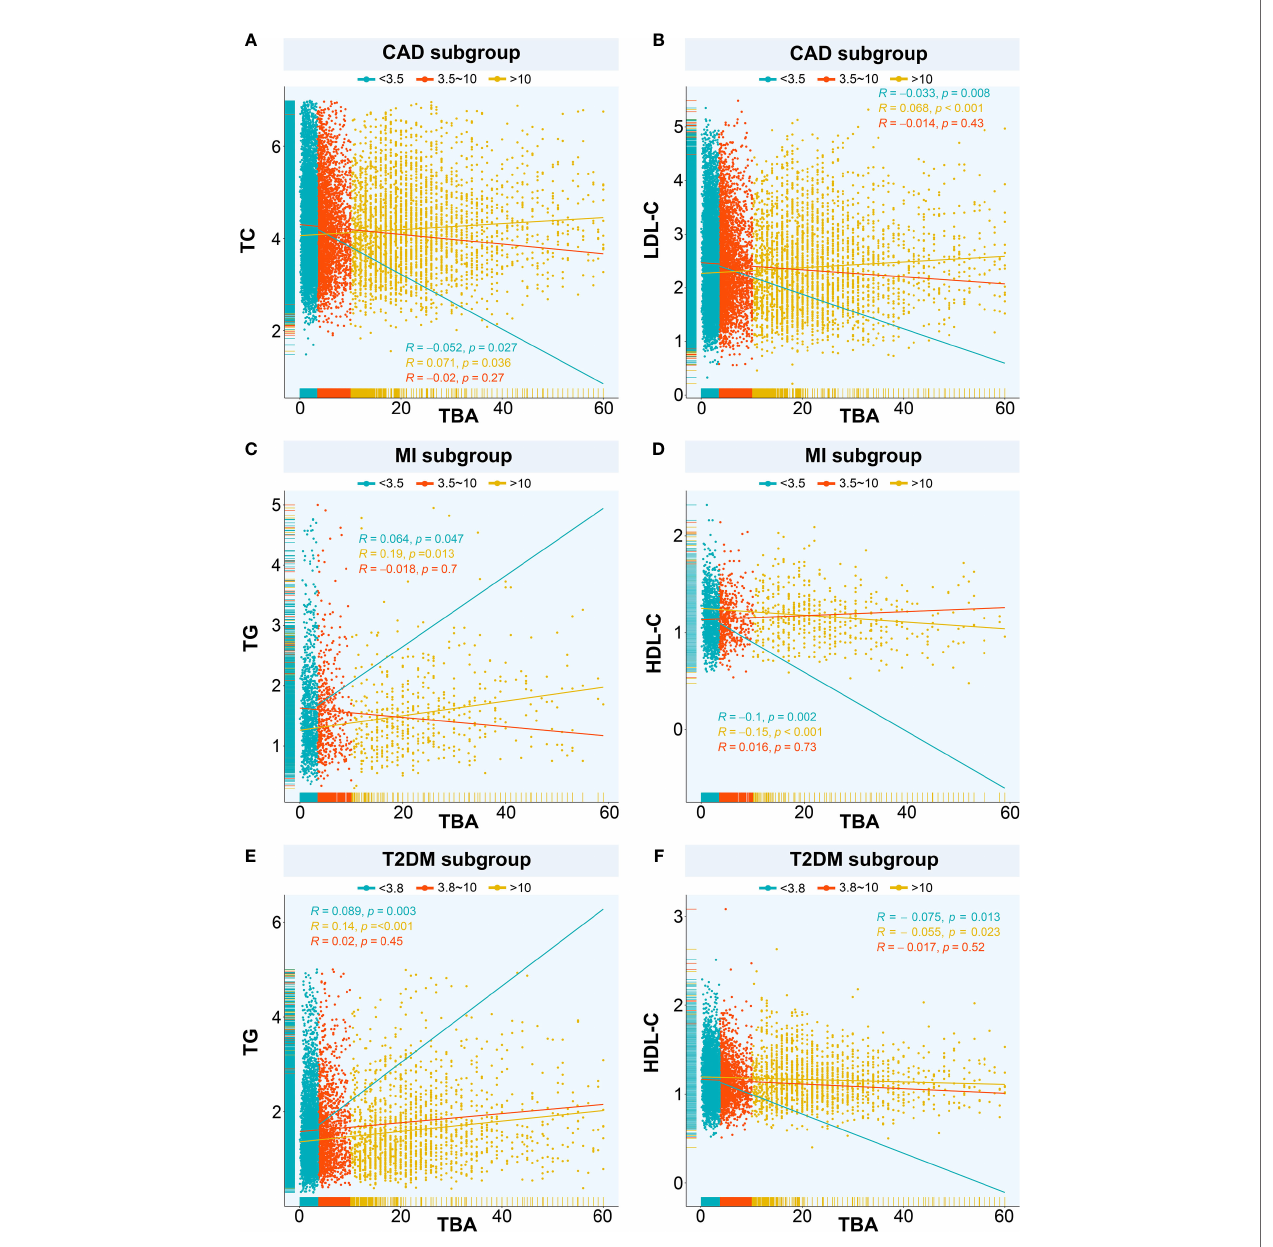
FIGURE 2 | Relationships between TBA and lipids. The relationship between TBA and lipid composition in blood among the subgroups with different median TBA levels including (A) TBA and TC in CAD subgroup, (B) TBA and LDL-C in CAD subgroup, (C) TBA and TG in MI subgroup, (D) TBA and HDL-C in MI subgroup, (E) TBA and TG in T2DM subgroup, (F) TBA and HDL-C in T2DM subgroup. TBA, total bile acid; CAD, coronary artery disease; TC, total cholesterol; LDL-C, low- density lipoprotein cholesterol; TG, triglyceride; HDL-C, high-density lipoprotein cholesterol; MI, myocardial infarction; T2DM, type 2 diabetes